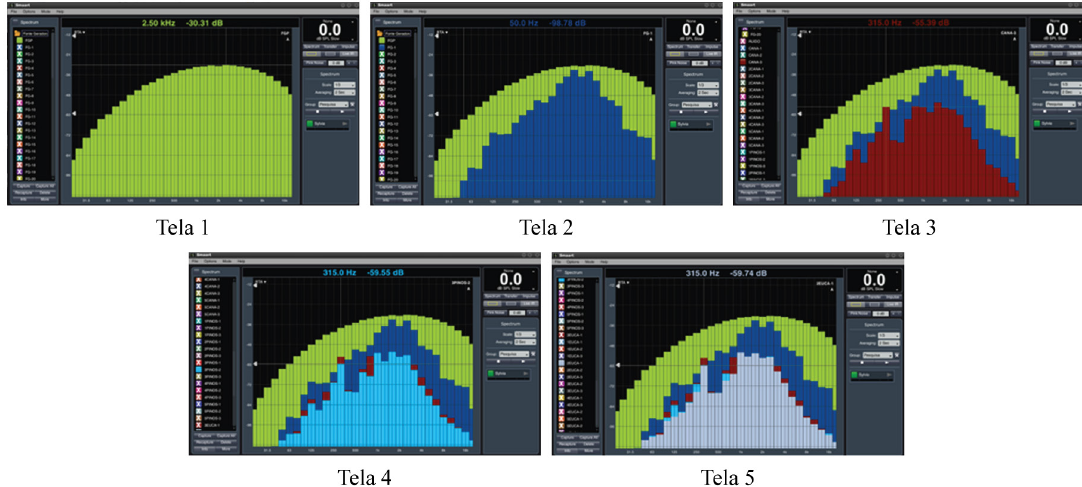
Figure 5. Records from the panels sound absorption areas created by the smaart software v7. Screen 1: pink noise; Screen 2: generating source; Screen 3: cane bagasse panel; Screen 4: Pinus sp. panel; Screen 5: Eucalyptus sp. panel. Table 1. Bulk Density (g/cm -3 ) and Moisture (%) of the Panels. Species